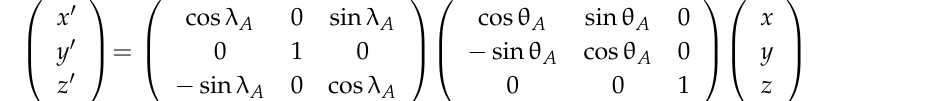
Figure 4. Direction of symmetry axis.